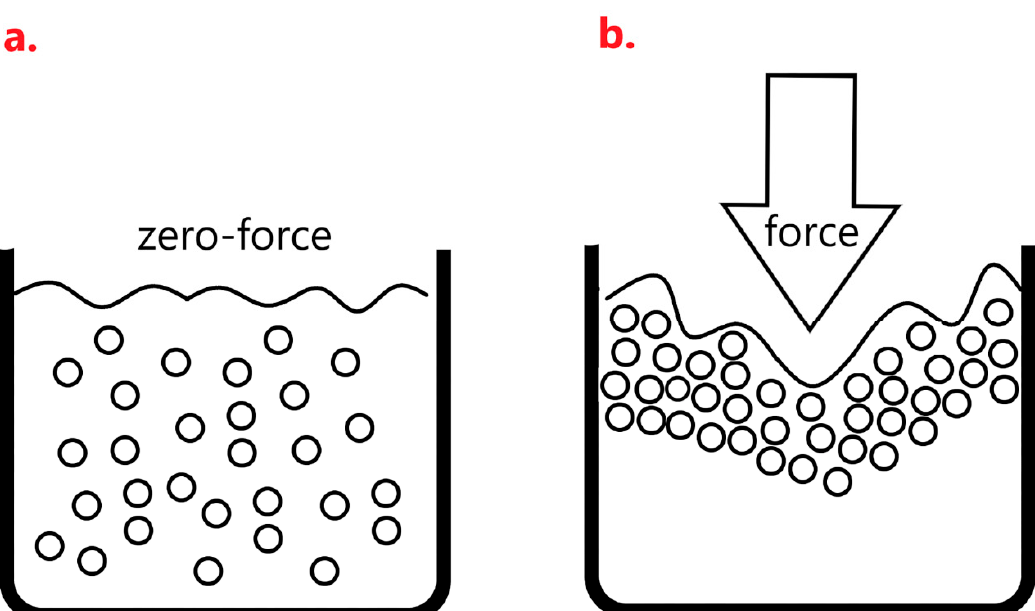
Figure 9. The difference in STF as to whether a compression force is exerted. ( a ) zero-force; ( b ) Force.